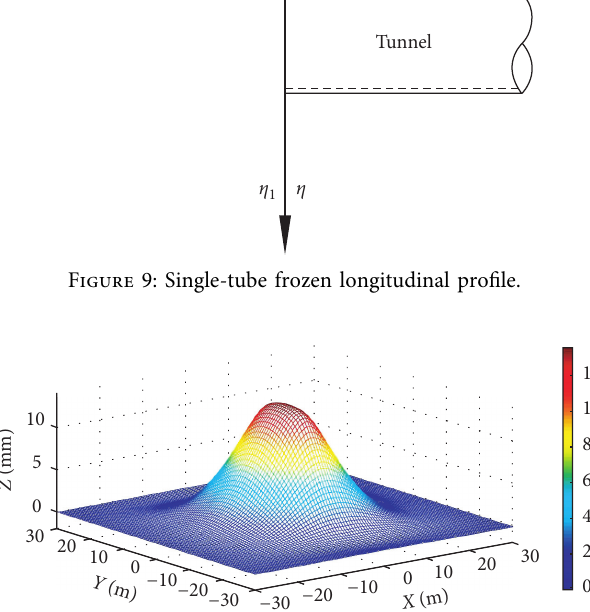
Figure 10: Heaving displacement of ground frost heave caused by freezing for 30 days (mm, α � 0 ° ).